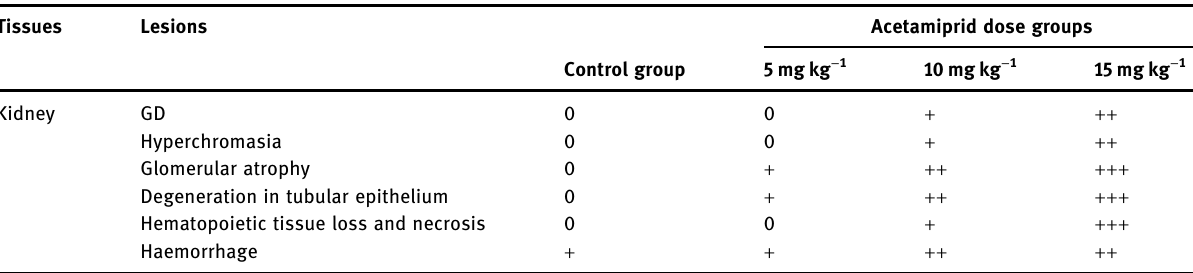
Table 2: Tissue change ratings of the histopathological lesions in the kidney tissue in Mus musculus var. albinos ( frequency ratings were adapted from Sakat et al. [ 16 ])